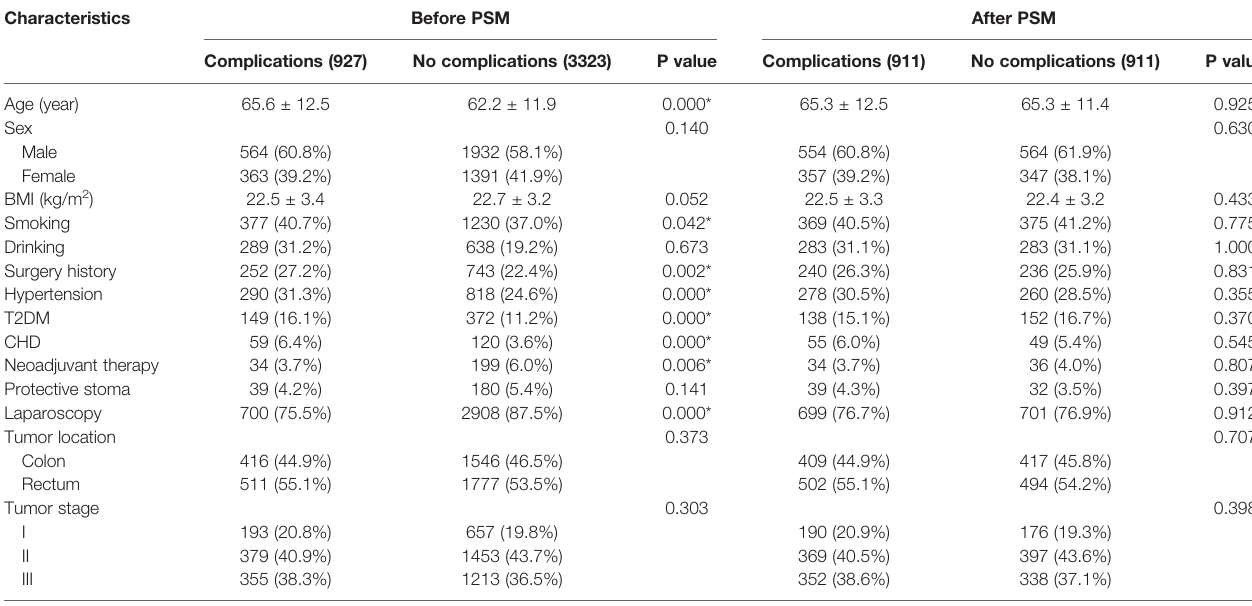
TABLE 1 | Baseline characteristics of included patients before and after PSM. Characteristics